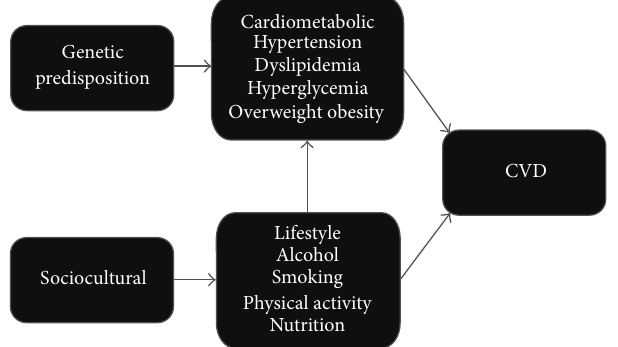
Figure 1: Causation pathway for cardiovascular disease (CVD)